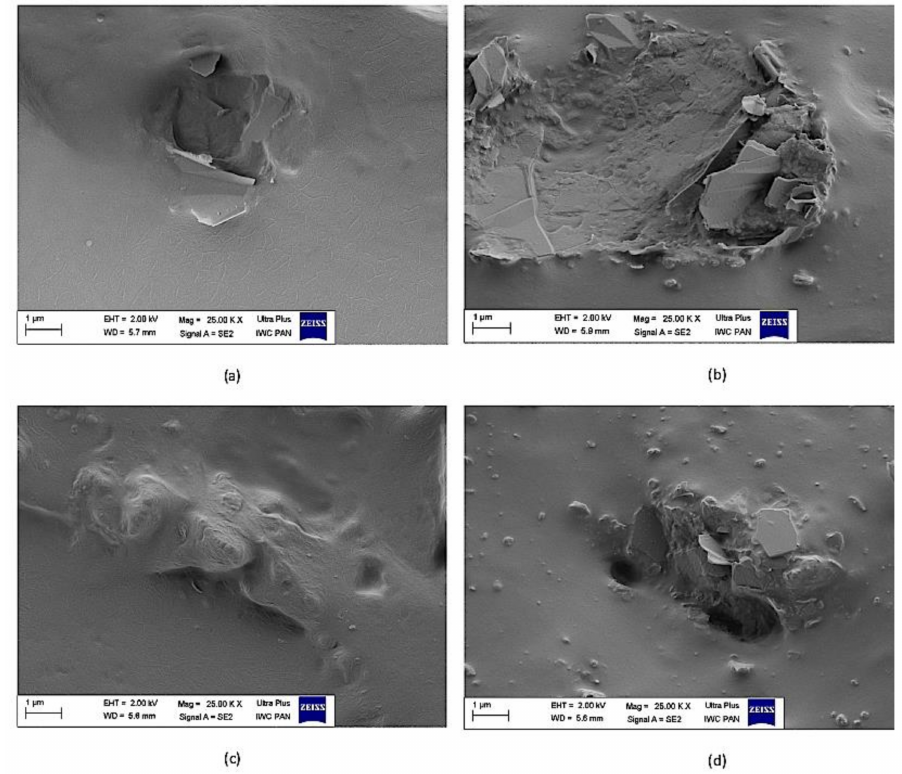
Figure 3. SEM micrographs of tested SBR composites filled with GnPs, modified in bulk with BMPFB: ( a ) 1phr of GnPs, ( b ) 4 phr of GnPs; and modified from solution with BMPFB: ( c ) 1phr of GnPs, ( d ) 4 phr of